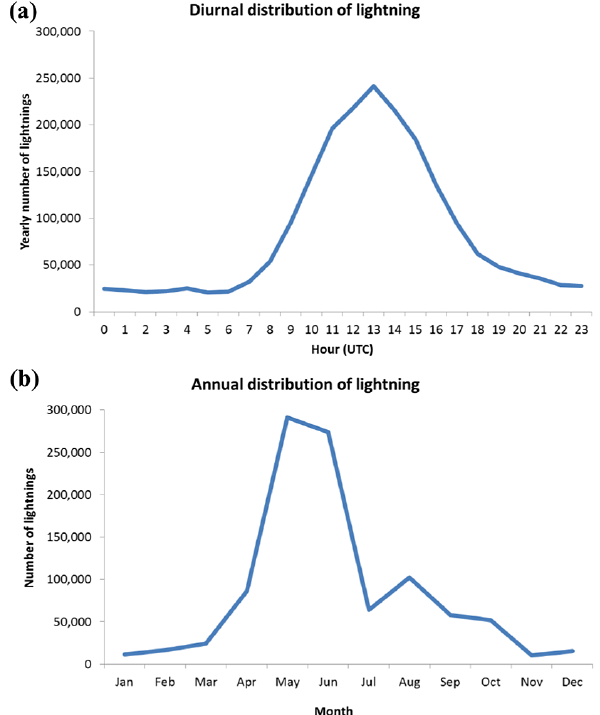
Figure 4. (a) Annual and (b) diurnal distribution of lightning over Turkey between 1 October 2011 and 30 September 2013. Local time in Turkey is UTC + 2 from October to March and UTC + 3 from April to September due to daylight saving time. Data were provided by